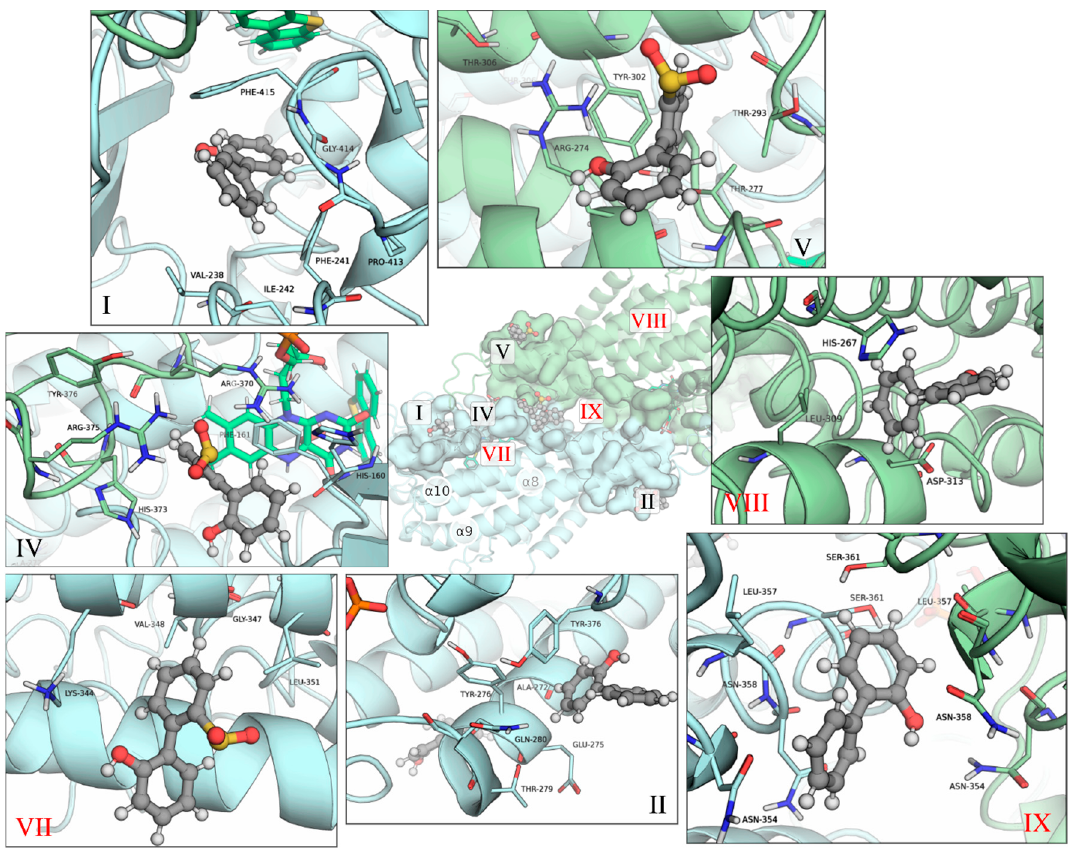
Figure 3. The sites where 2-HBP and HBPS bound most of the time. The residues with contacts within 3.5 Å of 2-HBP and HBPS are labeled and shown in stick representation. Binding sites that di ff er from the predicted in the docking calculations are labeled red (VII, VIII, and IX).